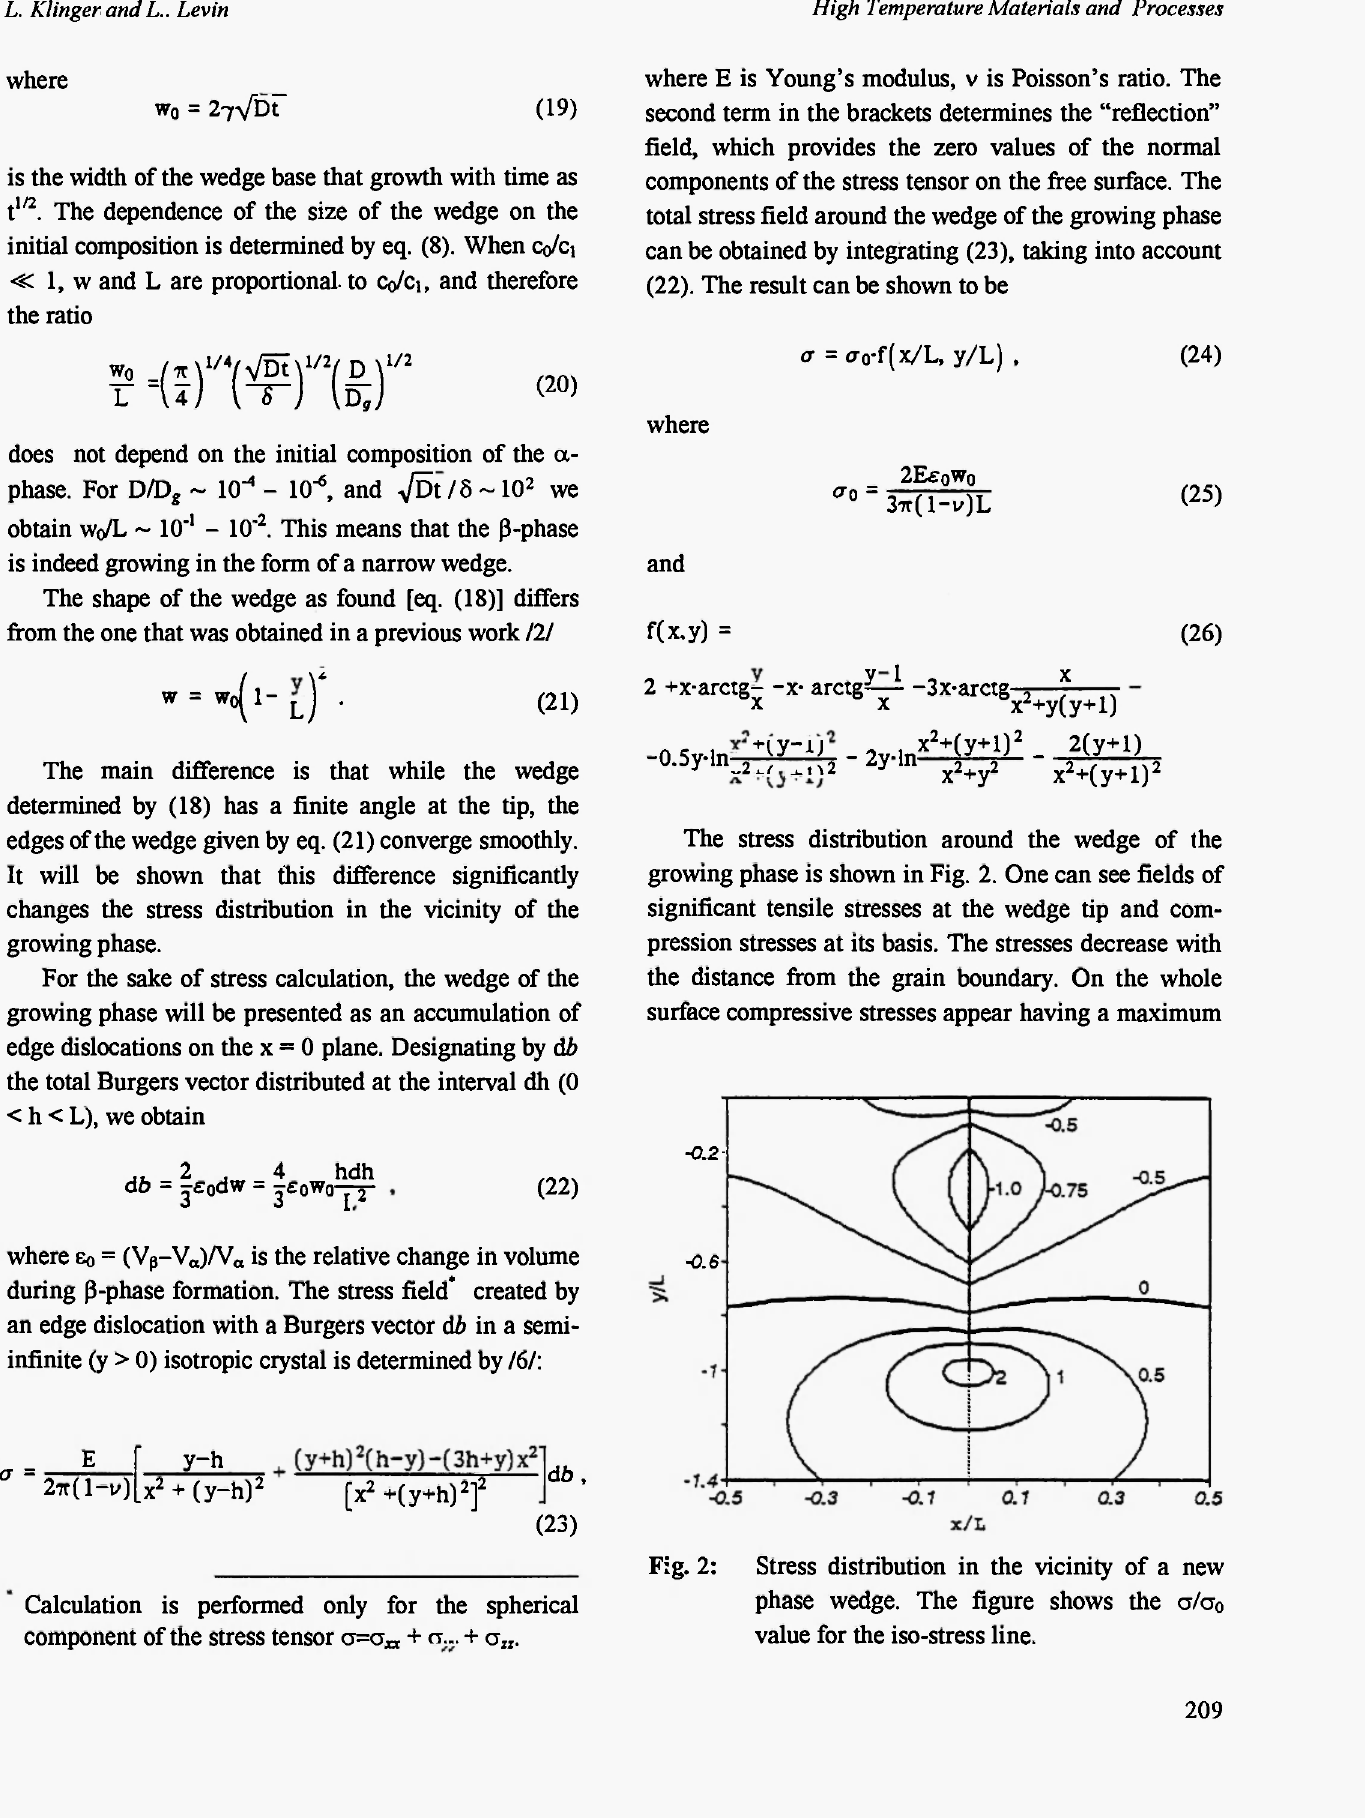
Fig. 2: Stress distribution in the vicinity of a new phase wedge. The figure shows the σ/σ value for the iso-stress